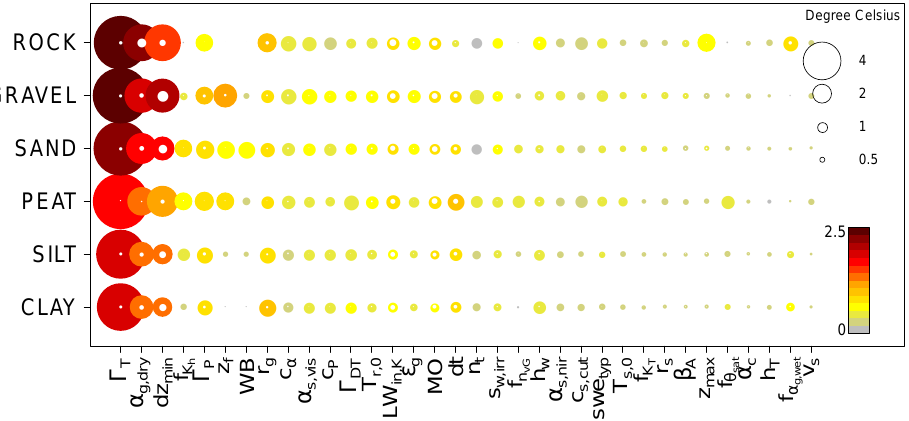
Fig. 9. Sensitivities of topographic sensitivity summarized as the 5, 50 and 95% percentiles of MAGT modeled at 1m depth for all ground types. The area of the circle indicates the 95% percentile, and the area of the white dot the 5% percentile of the sensitivity, summarized for all topographic locations. The color indicates the median